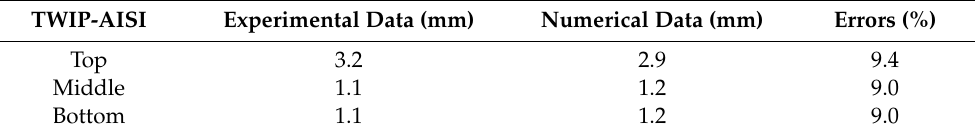
Table 6. Table of experimental and numerical dimensions of the TWIP-AISI fusion zone.